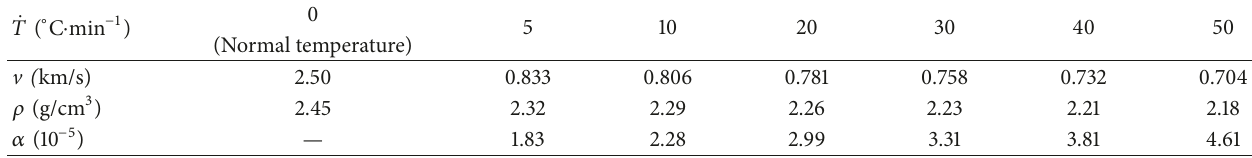
Table 2: Physical parameters of sandstone under different heating rates.